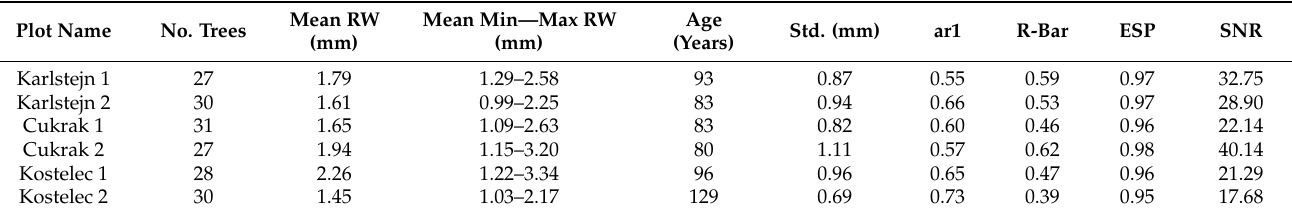
Table 2. Characteristics of tree-ring chronologies for Norway spruce in research